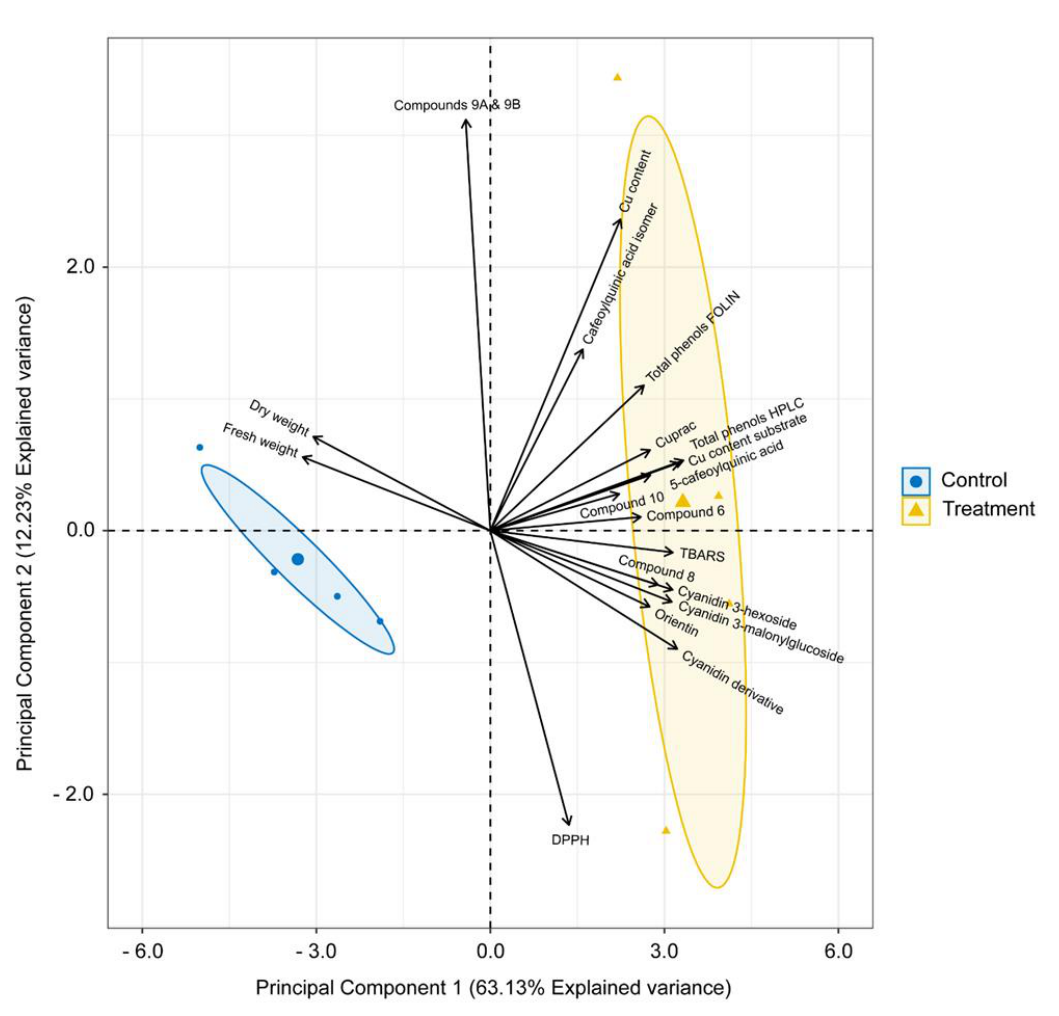
Figure 5. Principal component analysis (PCA) with scores for the respective association between Cu exposure during 21 days on I. cylindrica shoot and their variables analyzed. Control conditions (without Cu applied) and treatment (300 mg Cu kg − 1 substrate). The mean value was used in each situation.